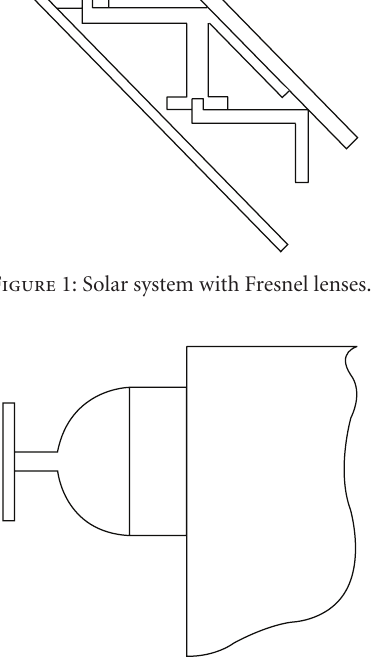
Figure 2: Solar water distillation system by electrical power generation.